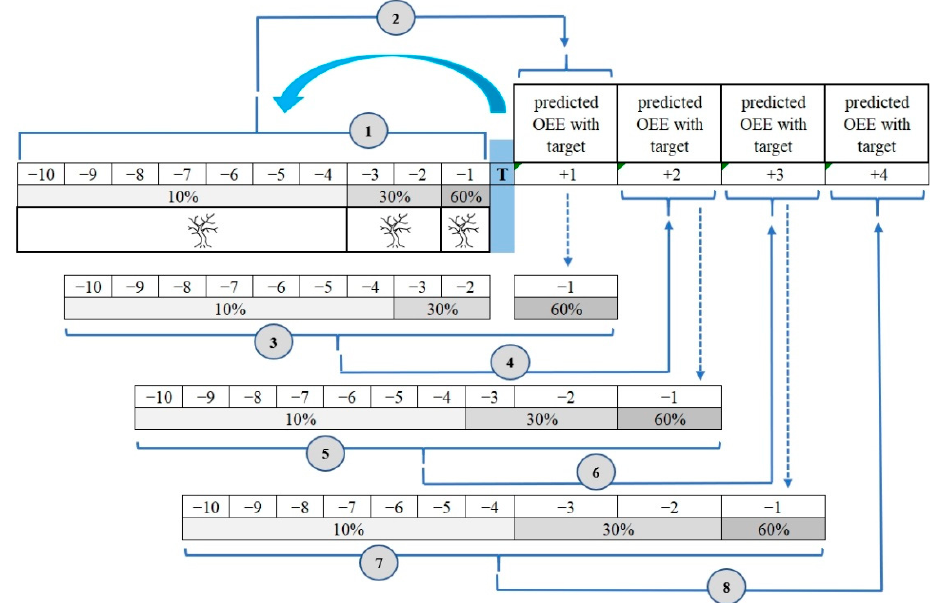
Figure 8. Target ‐ oriented OEE prediction based on decision tree. Figure 8. Target-oriented OEE prediction based on decision